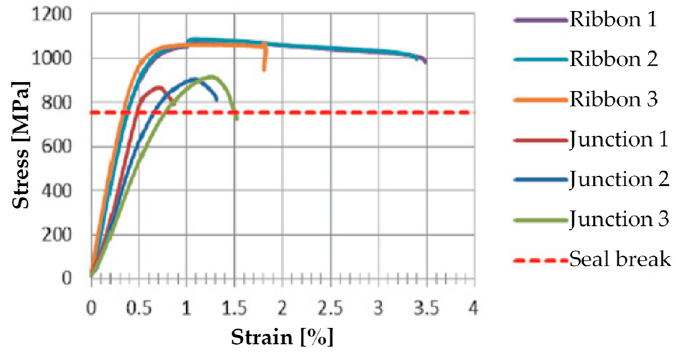
Figure 26. Stress/strain diagrams of the CAM ribbons, with and without seals [7].